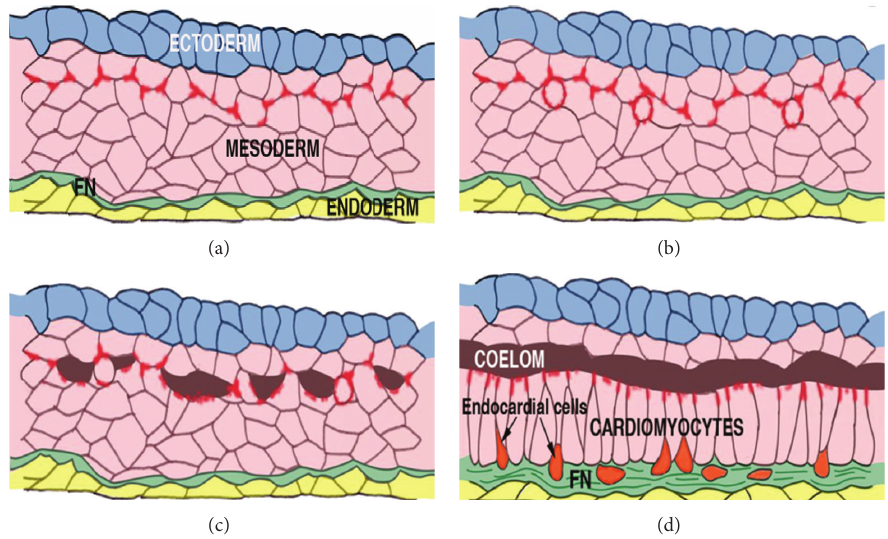
Figure 2: Diagrams depicting the temporal sequence of vertebrate cardiomyocyte differentiation. (a) In the gastrula stage embryo, in the most undifferentiatedpartofthecardiogeniccrescent 𝛽 -cateninlocalization,animportantintermediaryofWntsignalingappearsatcellboundaries within the mesoderm. (b) Within this region soon round 𝛽 -catenin-expressing cells are seen. (c) Near these round cells, pericardial coelomata (depicted as black areas) form, as cardiomyocytes change from a mesenchymal organization and elongate to form an epithelial, ventral cardiac compartment. A more ventral population not part of the epithelium now move more ventrally to a fibronectin-rich matrix (green), where these cells (orange) differentiate into endothelial endocardial cells. See Linask review, 2003